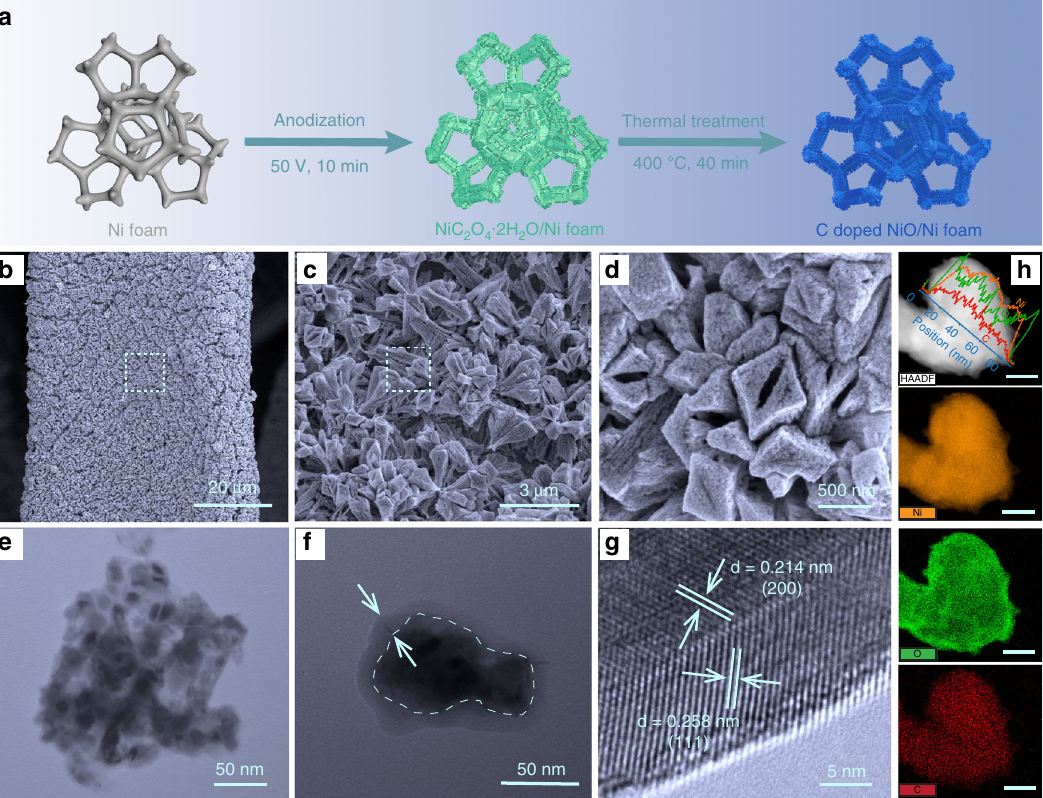
Fig. 2 Preparation and structural characterization of C-doped NiO. a Schematic illustration of the synthesis of carbon doped NiO on NF. b – d SEM images of the C-doped NiO nanorod/NF in different magni fi cations. The regions highlighted by dashed boxes in ( b ) and ( c ) are magni fi ed in ( c ) and ( d ), respectively. e – f TEM images of the fragments of C-doped NiO nanorod/NF. g A HR-TEM image collected at the edge of the nanoparticle in ( f ). h High- angle annular dark fi eld (HAADF)-TEM image of a Ni core/NiO shell particle and the corresponding EELS elemental mapping of Ni, O, and C (scale bars are 20